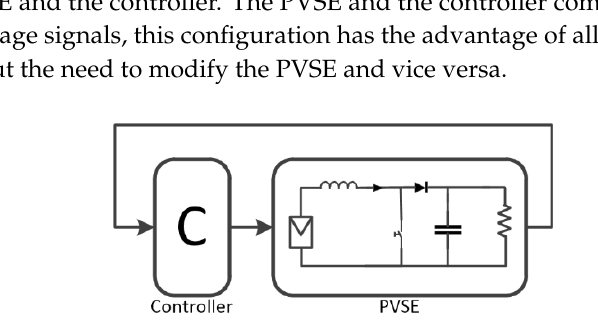
Figure 2. Block diagram of the photovoltaic system emulator (PVSE) and the controller.